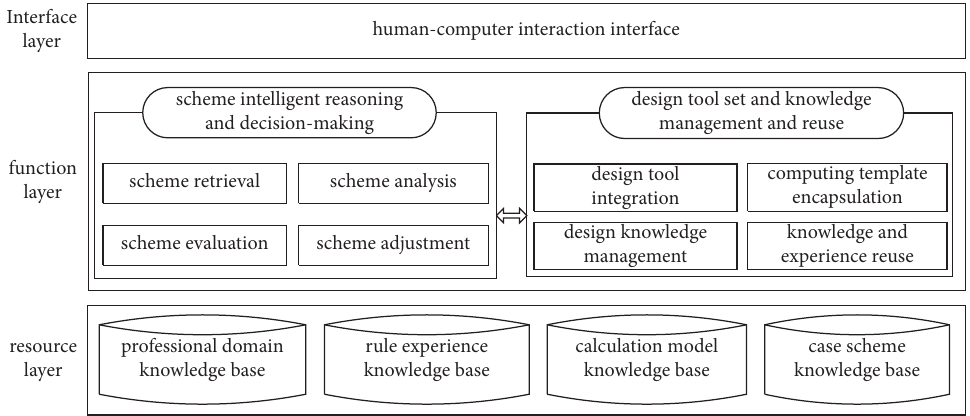
Figure 5: Technical system structure of the intelligent product